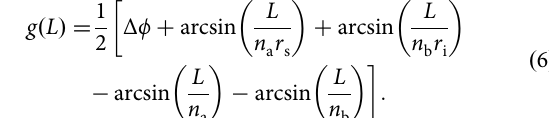
Dividing Eq. (1) by (2) and integrating between radii r 0 and r 1 ,